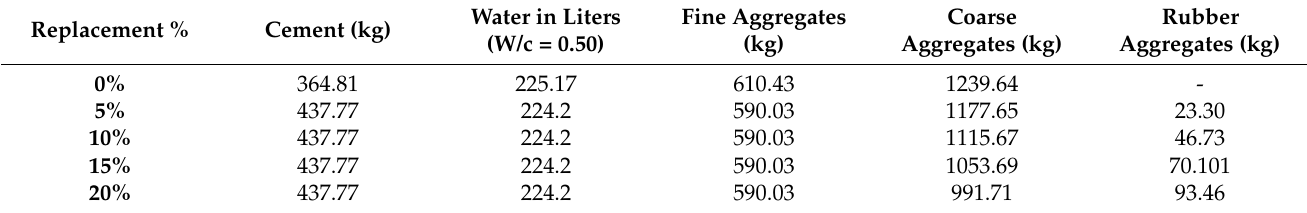
Table 1. Mix proportion (kg/m 3 ) of the rubber concrete [32]. Copyright© 2017, Elsevier B.V.